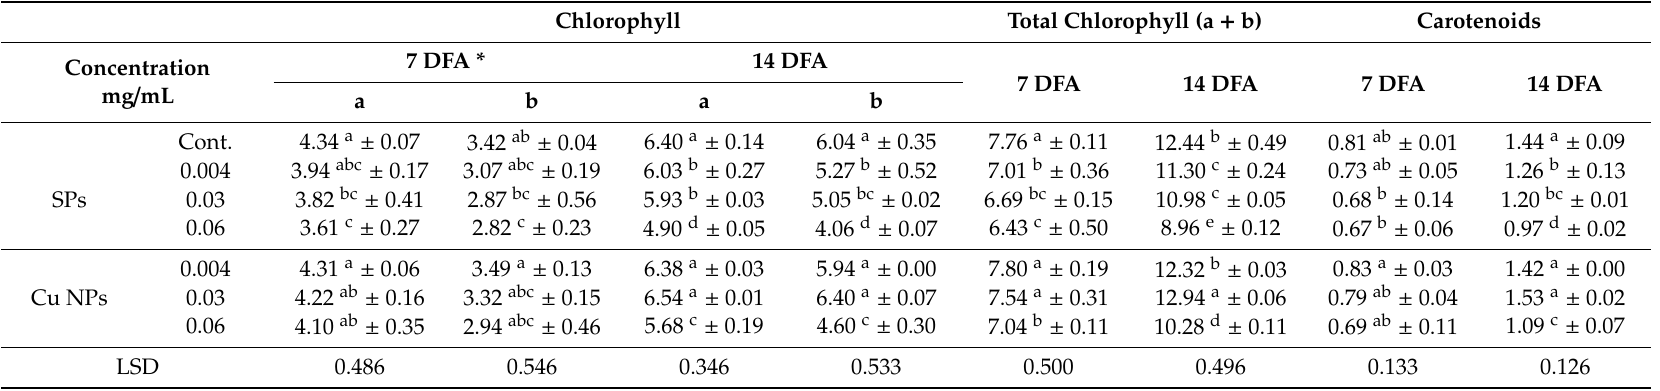
Table 4. Chlorophyll and carotenoids contents (mg / g fresh weight) in wheat leaves exposed to a foliar application of SPs and Cu NPs. Chlorophyll Total Chlorophyll (a + b)